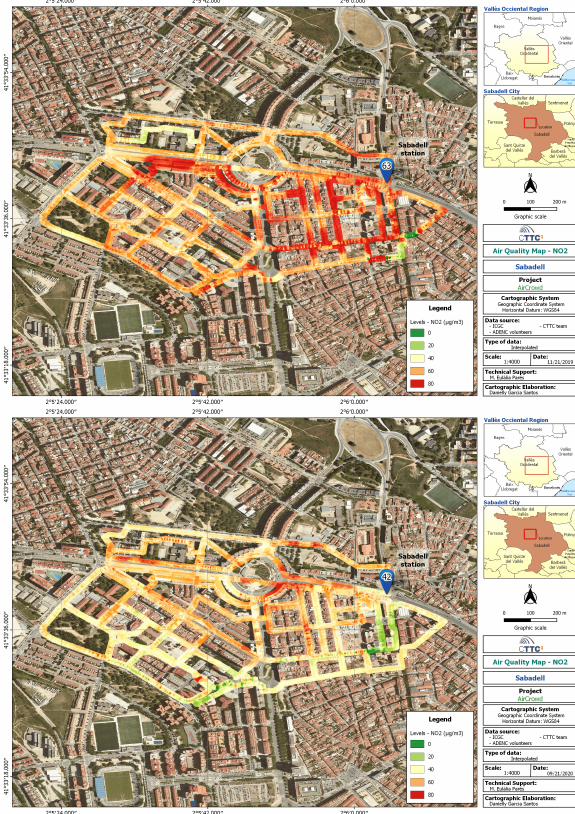
Figure 7. Data set Top.- at 7:30 of a winter’s Thursday and Bottom.- at 7:30 on a winters Saturday